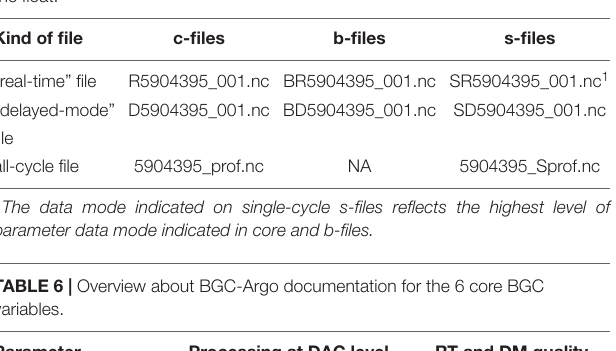
TABLE 5 | Example of the file naming scheme for a float with WMO number 5904395. Note that either a “real-time” c-/b-/s-file or a “delayed-mode” c-/b-/s-file exists, not both. The all-cycle file contains all available cycles for the float.